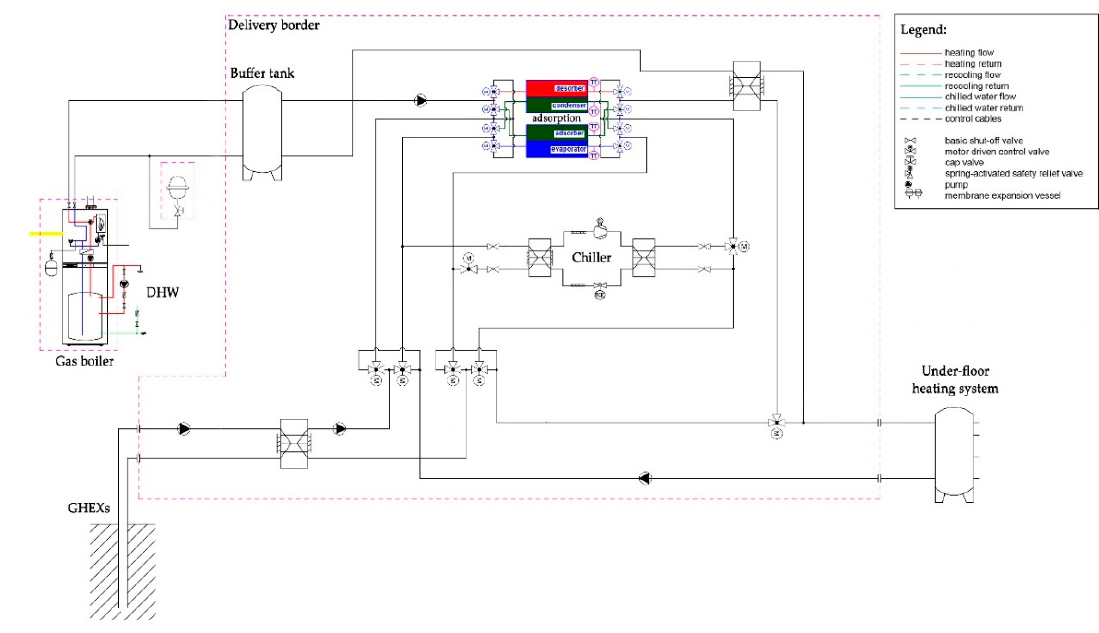
Figure 8. Hydraulic scheme of the plant.